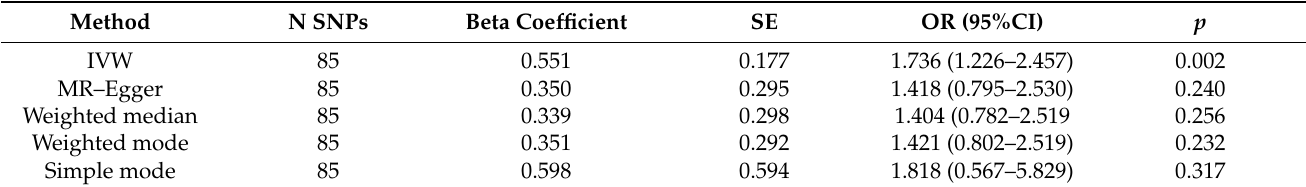
Table 1. Two-sample Mendelian randomization for PM2.5 on GDM